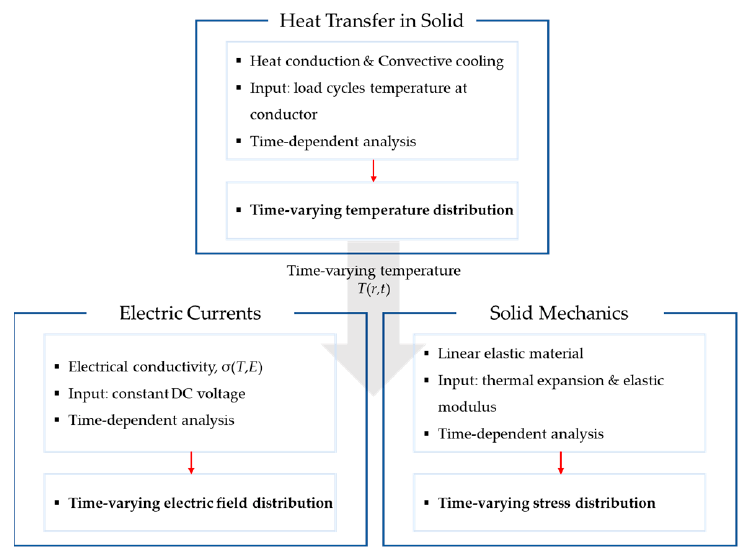
Figure 2. Multiphysics coupling process in COMSOL 6.0 software.